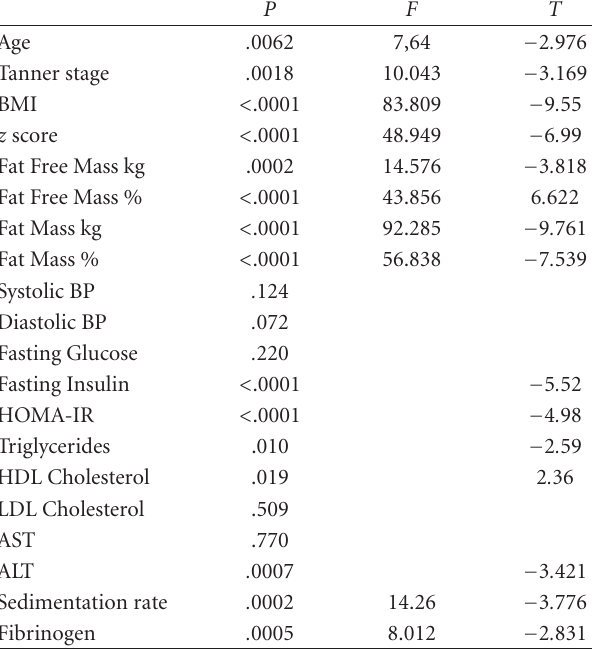
Table 2: Univariate regression analysis between VO 2max and metabolic risk